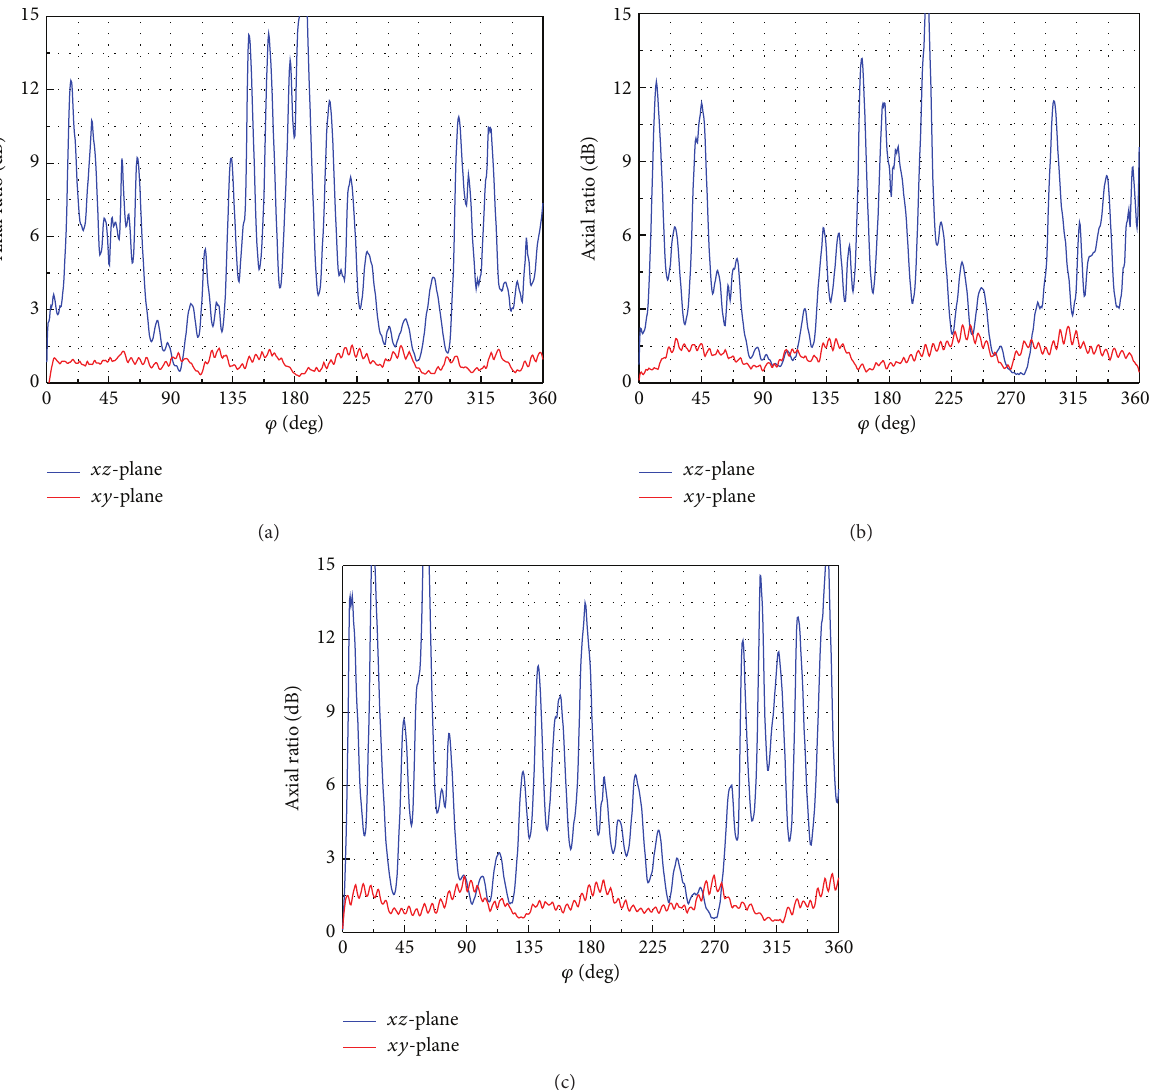
Figure 6: Measured axial ratio patterns in 𝑥𝑦 -plane and 𝑥𝑧 -plane. (a) 5.1 GHz, (b) 5.5 GHz, and (c) 5.9